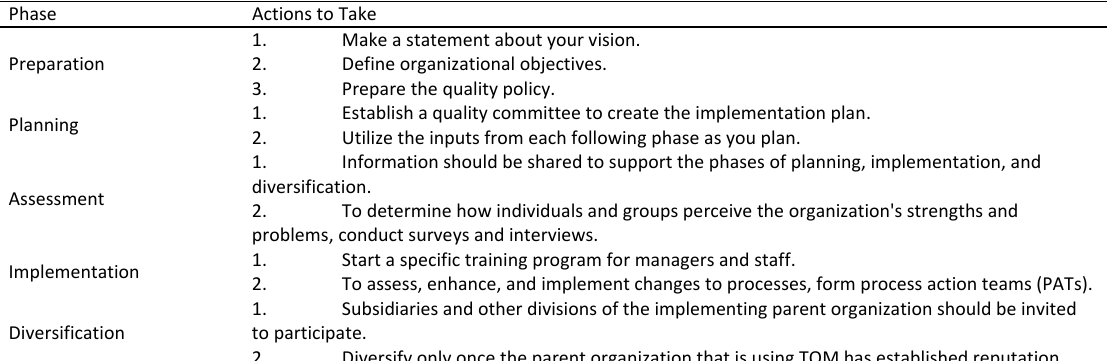
Table 2: Description of five phases for implementation for TQM (Andres, 1996)